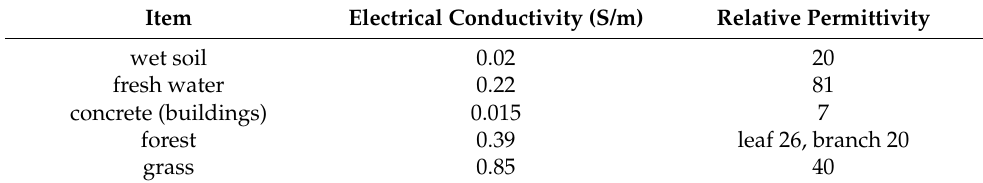
Figure 6. The calculation area in the PE model and its topographic map with elevation: ( a ) beam- covered area. ( b ) The elevation distribution. Table 1. Electromagnetic parameters of different